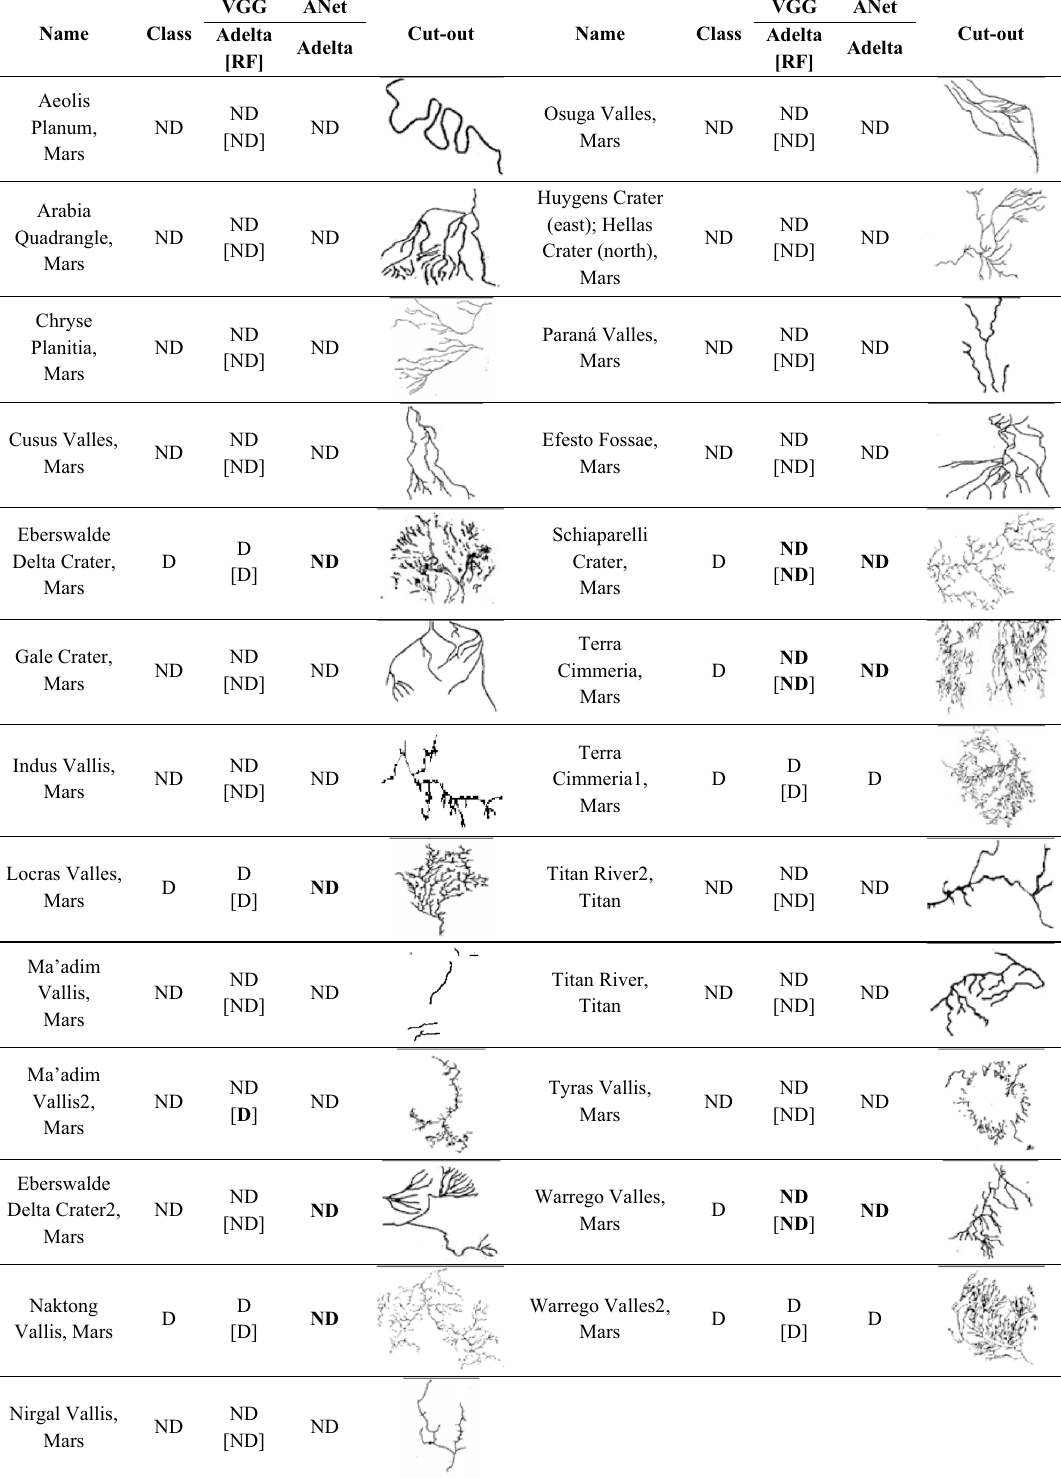
Table 4. Extraterrestrial drainage networks classified by the three models trained on terrestrial samples. The target class (columns 2 and 7) was assigned by human experts: D is dendritic, ND non-dendritic. In columns 3 and 8, the double class value refers to the results obtained, respectively, by the VGG + Adadelta (upper value) and by the VGG + RF models (lower value in square brackets). Mismatches in the class are highlighted in